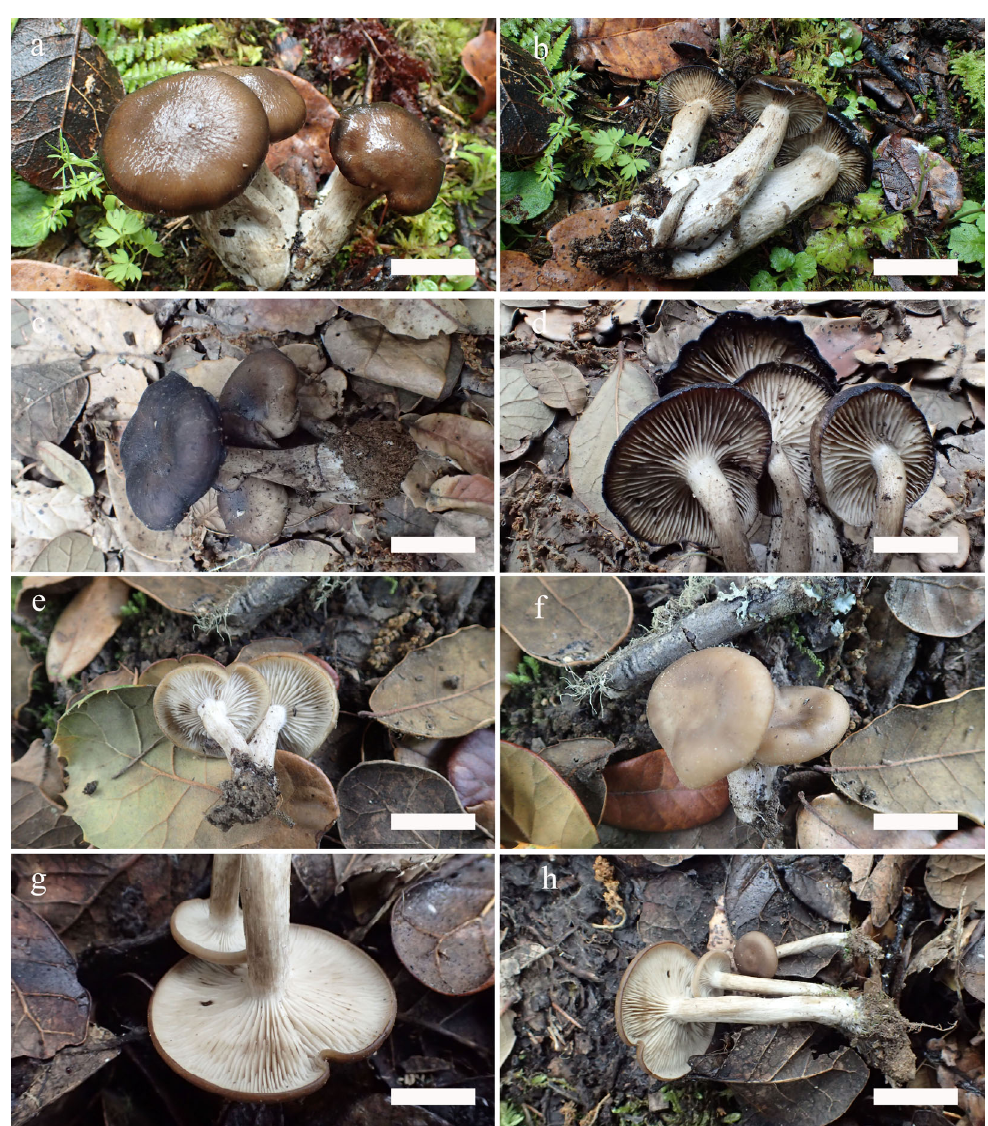
Figure 2. Basidiomata of Lyophyllum . ( a – d ) L. atrofuscum , ( a , b ) HMJAU63461; ( c , d ) HMJAU63456! holotype. ( e – h ) L. subalpinarum, ( e , f ) HMJAU63447! holotype; ( g , h ) HMJAU63453. Scale bars: ( a , d ) 4 cm; ( b ) 5 cm; ( c ) 3 cm; ( e – g ) 2 cm; ( h ) 3 cm.